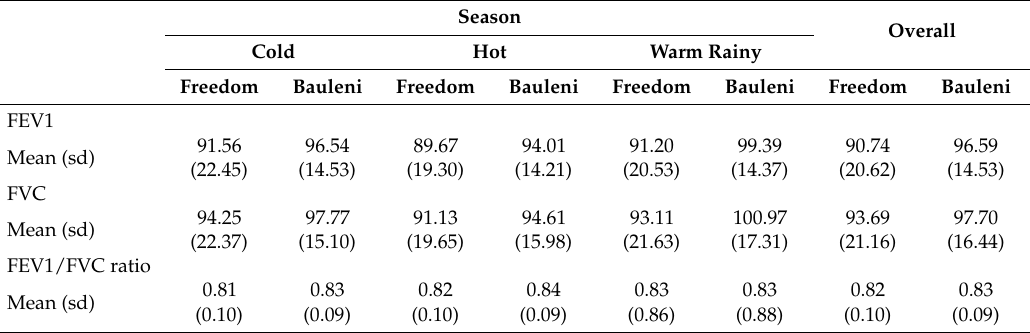
Table 4. Percent predicted lung function variations between communities and season.